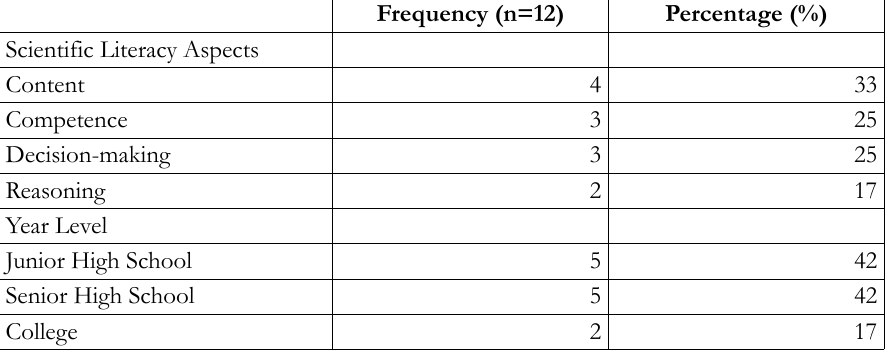
Table 3. Number of Articles according to science literacy aspects, year level, and use of SSI